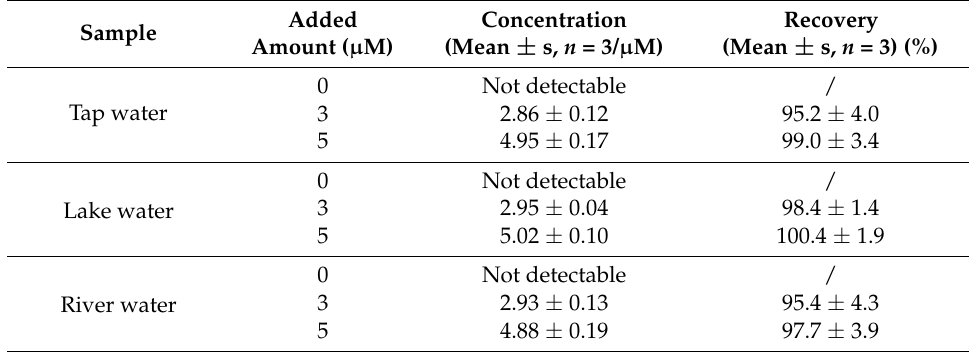
Table 2. Analytical results for the determination of As(III) in environmental water samples by proposed colorimetric